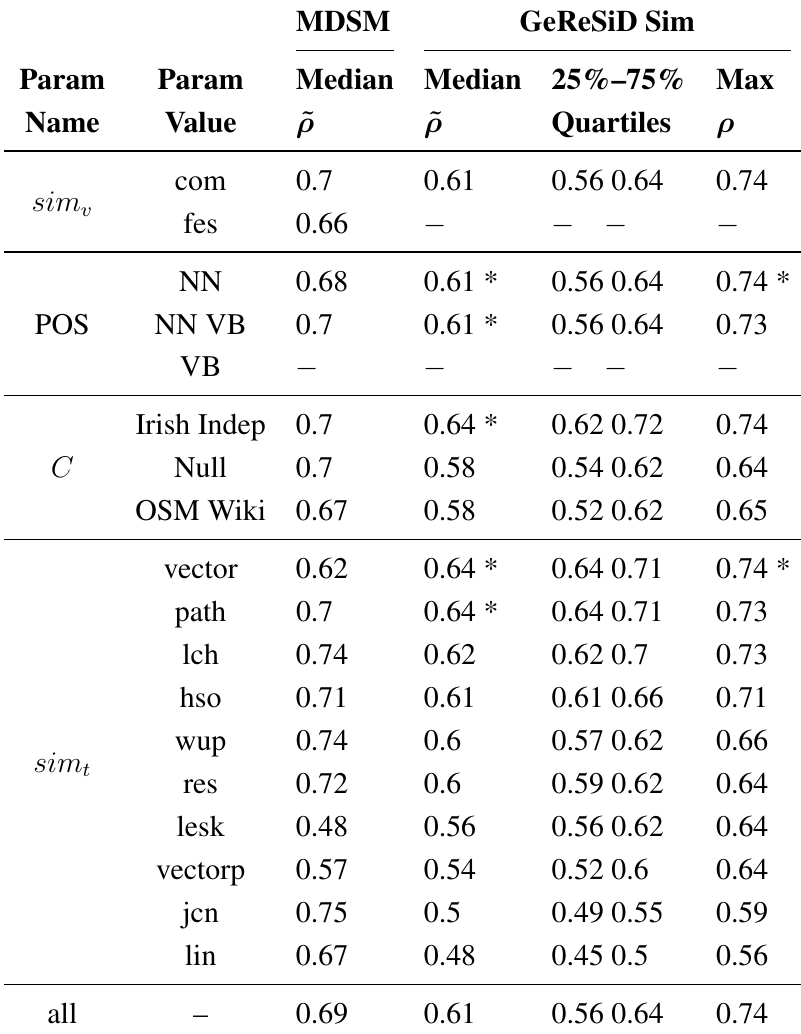
Table 5. Results of the lexical similarity experiment. MDSM results from